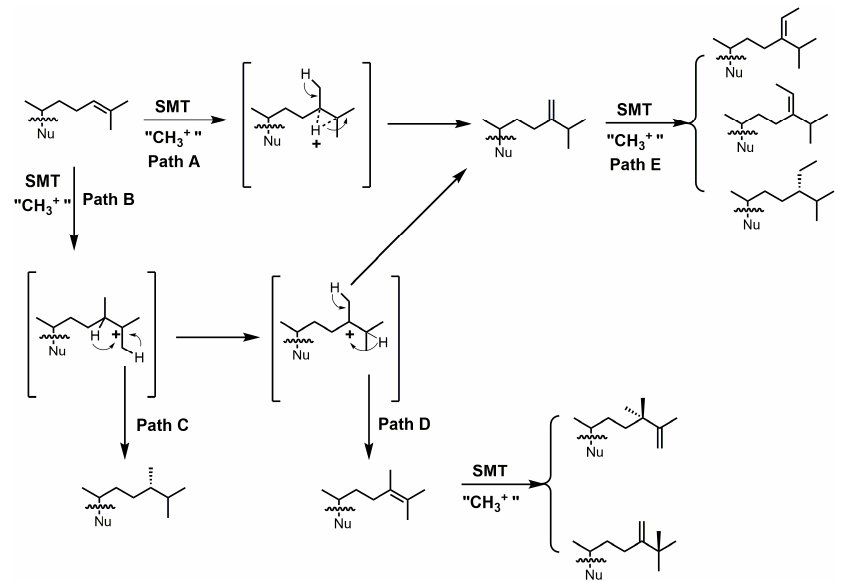
Figure 18. Different C24-alkylation pathways for sterol C24-methyltransferase (24-SMT) substrates (adapted from [4]). Nu: sterol nucleus.